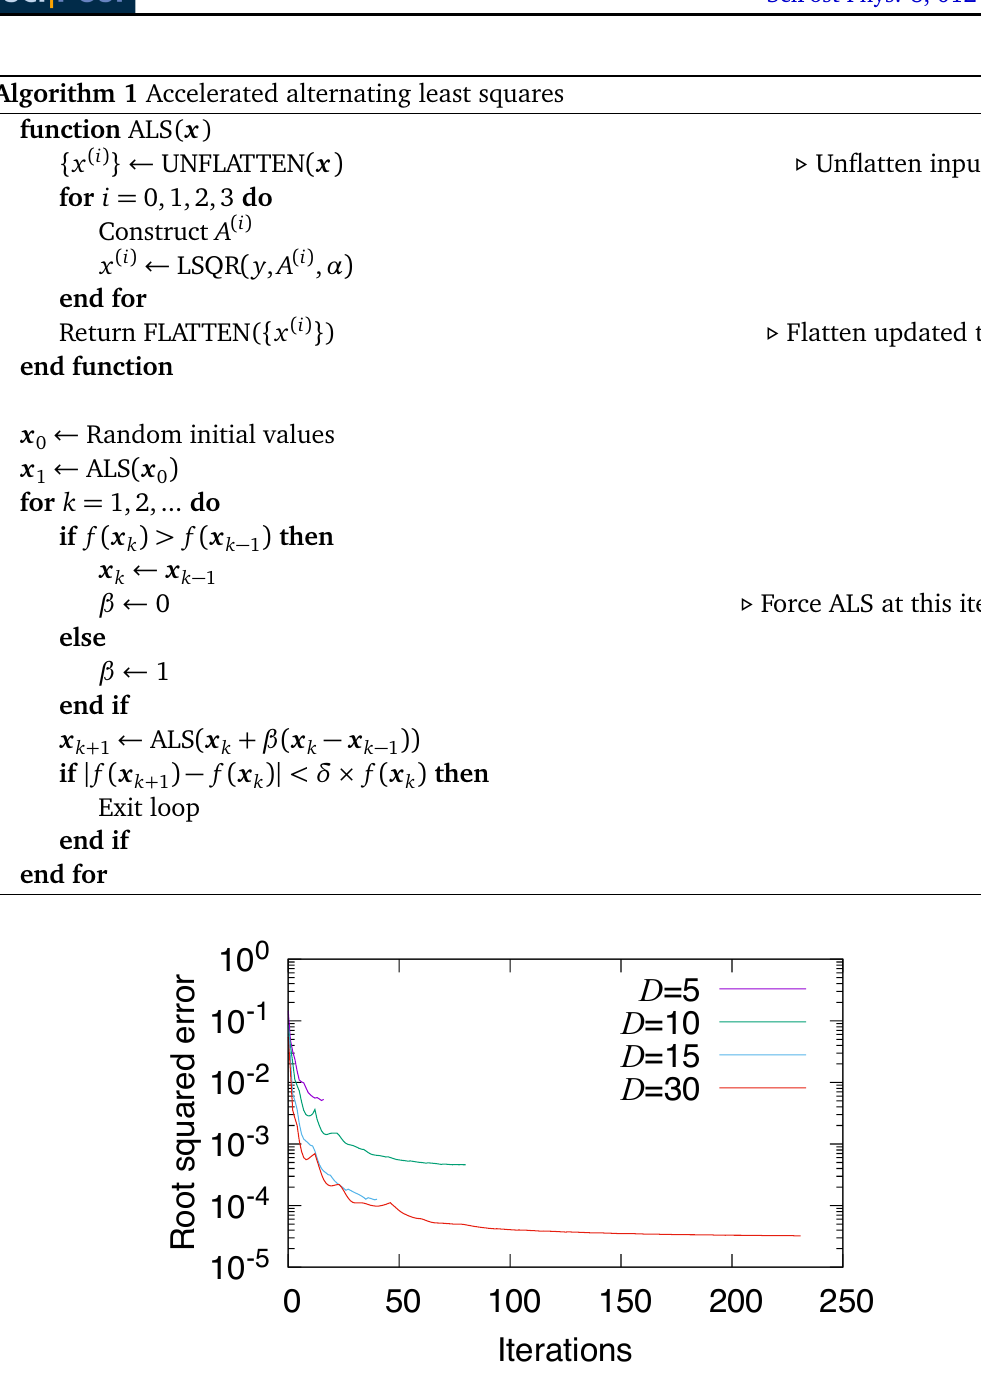
Figure 12: Convergence of root squared errors for the local susceptibility X loc of the single-band Hubbard model analyzed in Section